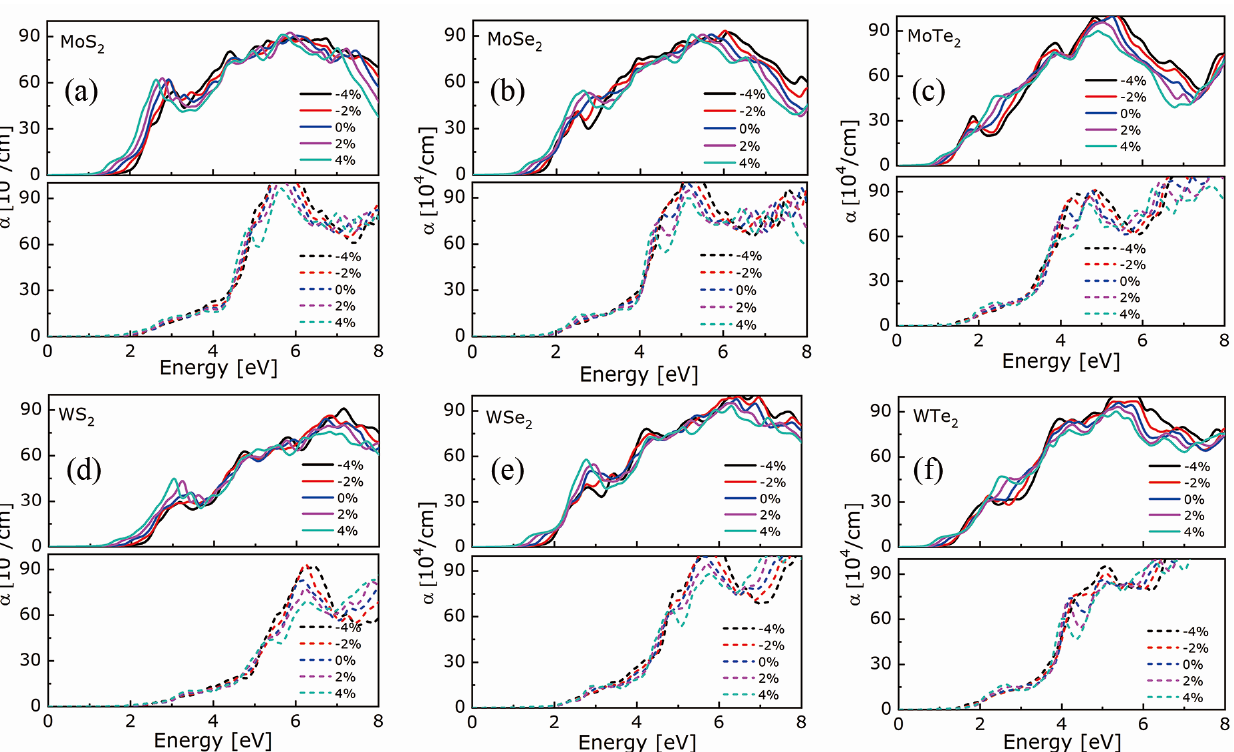
Figure 4. Absorption coefficients of ( a ) MoS 2 , ( b ) MoSe 2 , ( c ) MoTe 2 , ( d ) WS 2 , ( e ) WSe 2 , and ( f ) WTe 2 in the xx -(top panel) and zz -direction (bottom panel) as the biaxial strain goes from −4% to +4%.